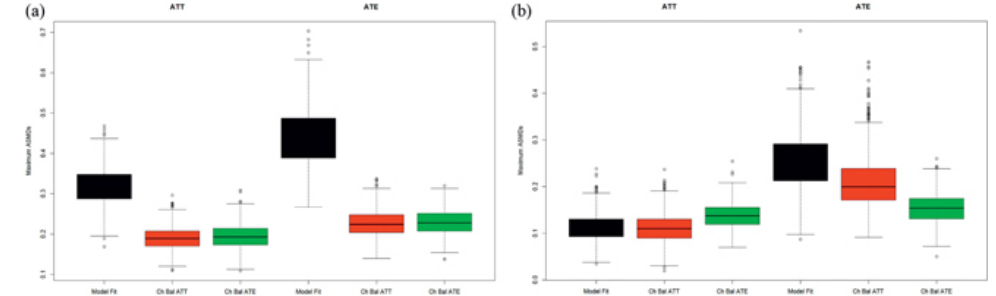
Figure 3: Maximum mean ASMD for Model A data generation but with all covariates used in propensity score estimation (distractors case) for (a) the PA and (b) the abstainers data generation case studies.